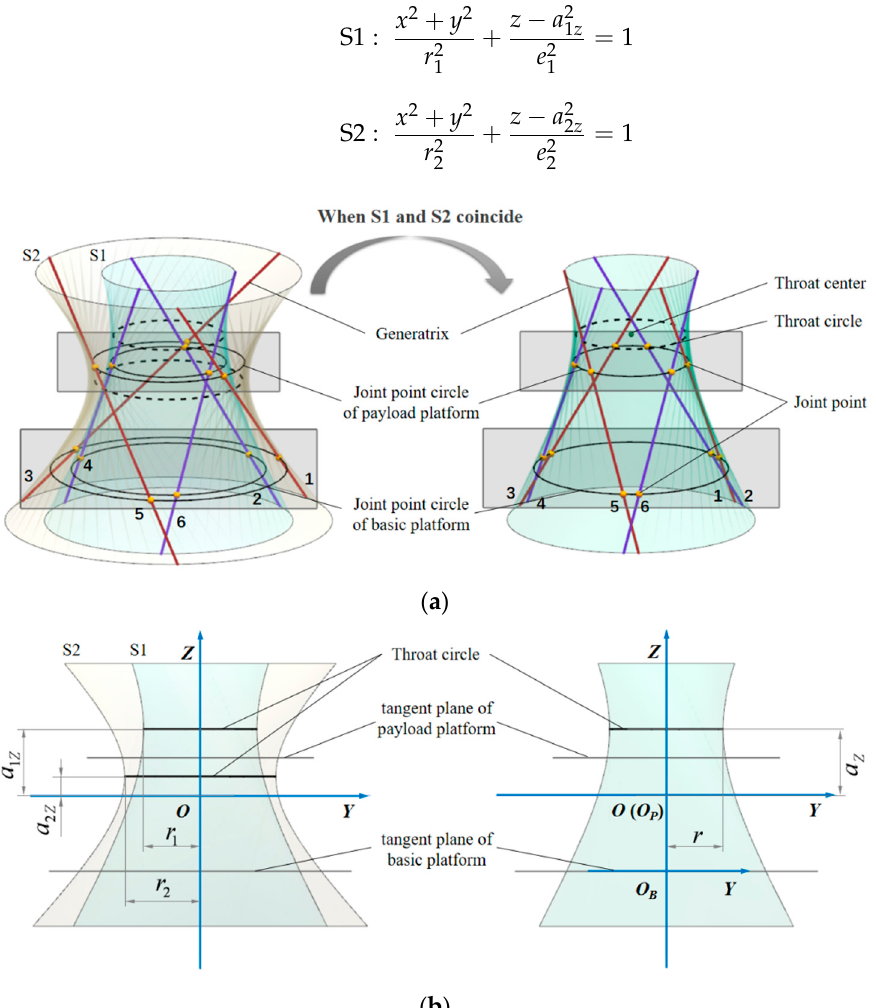
Figure 3. Diagram of Gough–Stewart configuration lying on the circle hyperboloid of one sheet: ( a ) schematic of configuration transformation; ( b ) diagram of parameters.